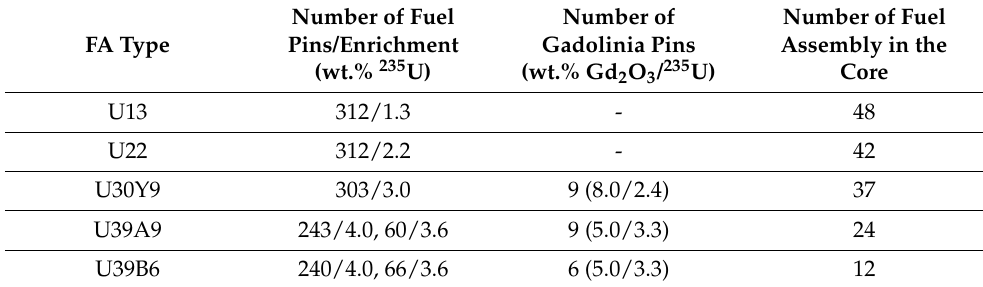
Table 2. Specification of Rostov-II fuel